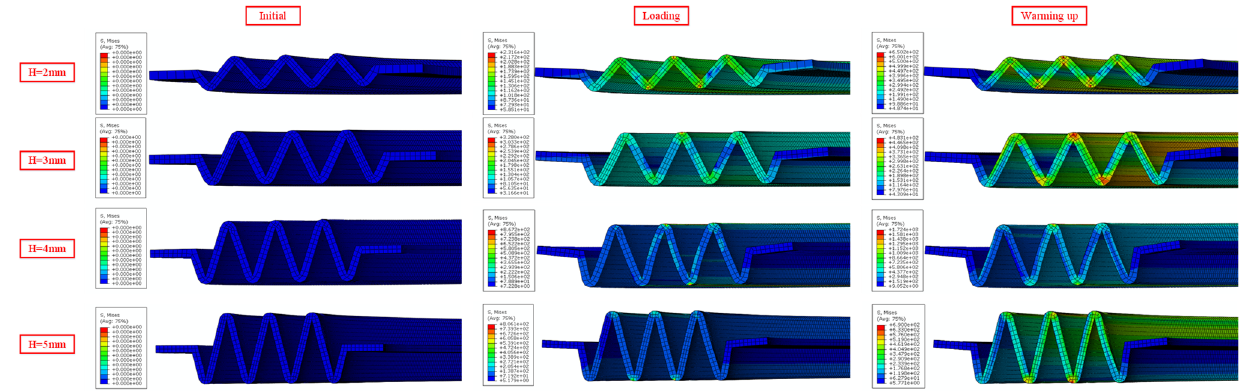
Figure 14. Deformation contours of NiTi alloy corrugated gasket with different heights.